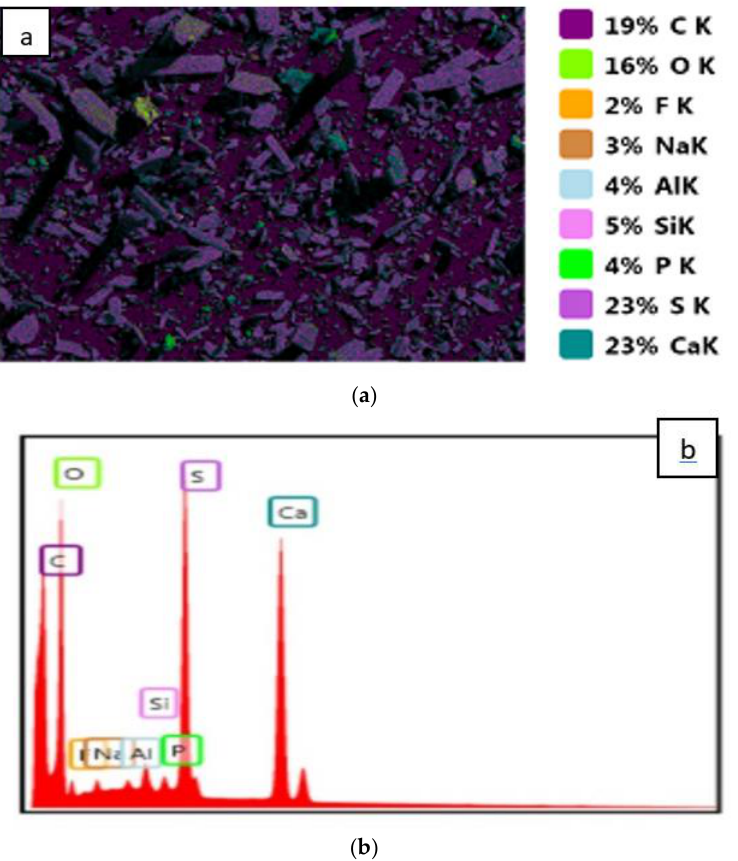
Figure 7. EDS results of PGW: Element map ( a ) and the quantitative ratio of the elements ( b ).